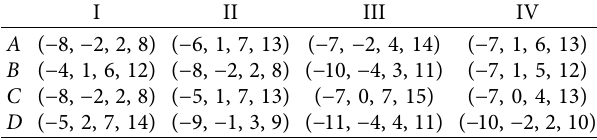
Table 12: Subtraction of the minimum interval in each row.